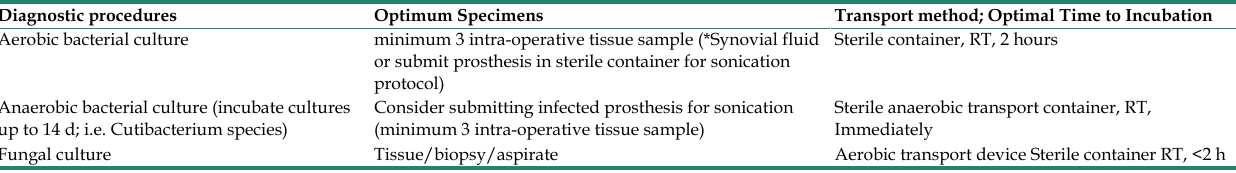
Table 2. IDSA Culture Recommendations for Prosthetic Joint and Surgical Site infections Diagnostic procedures Optimum Specimens protocol) Fungal culture